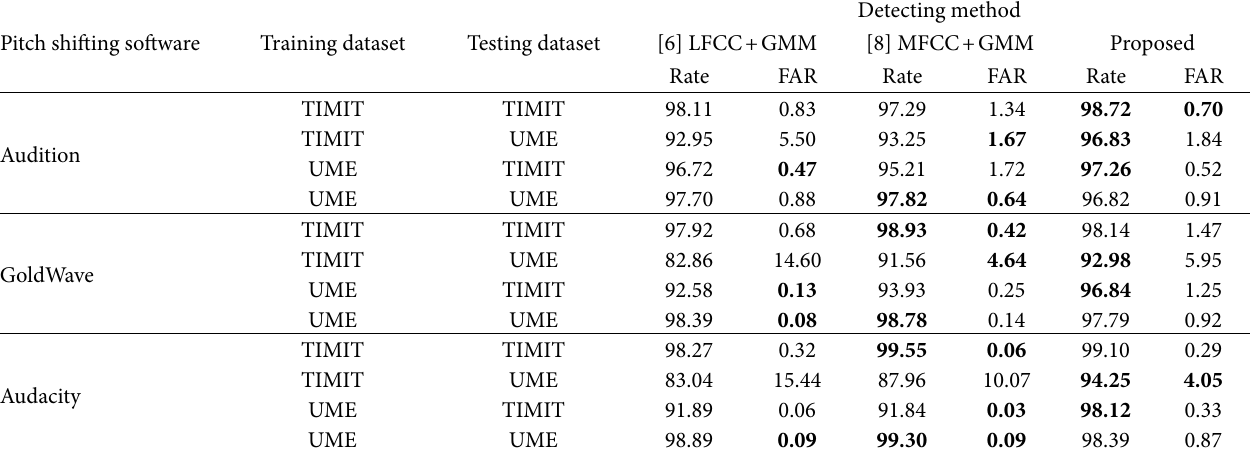
Table 3: Detection performance of weakly pitch-shifted voice in binary